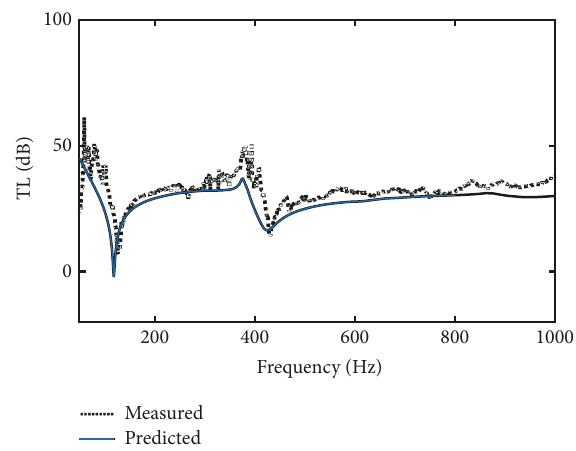
Figure 2: Comparison of the predictions and measured data.